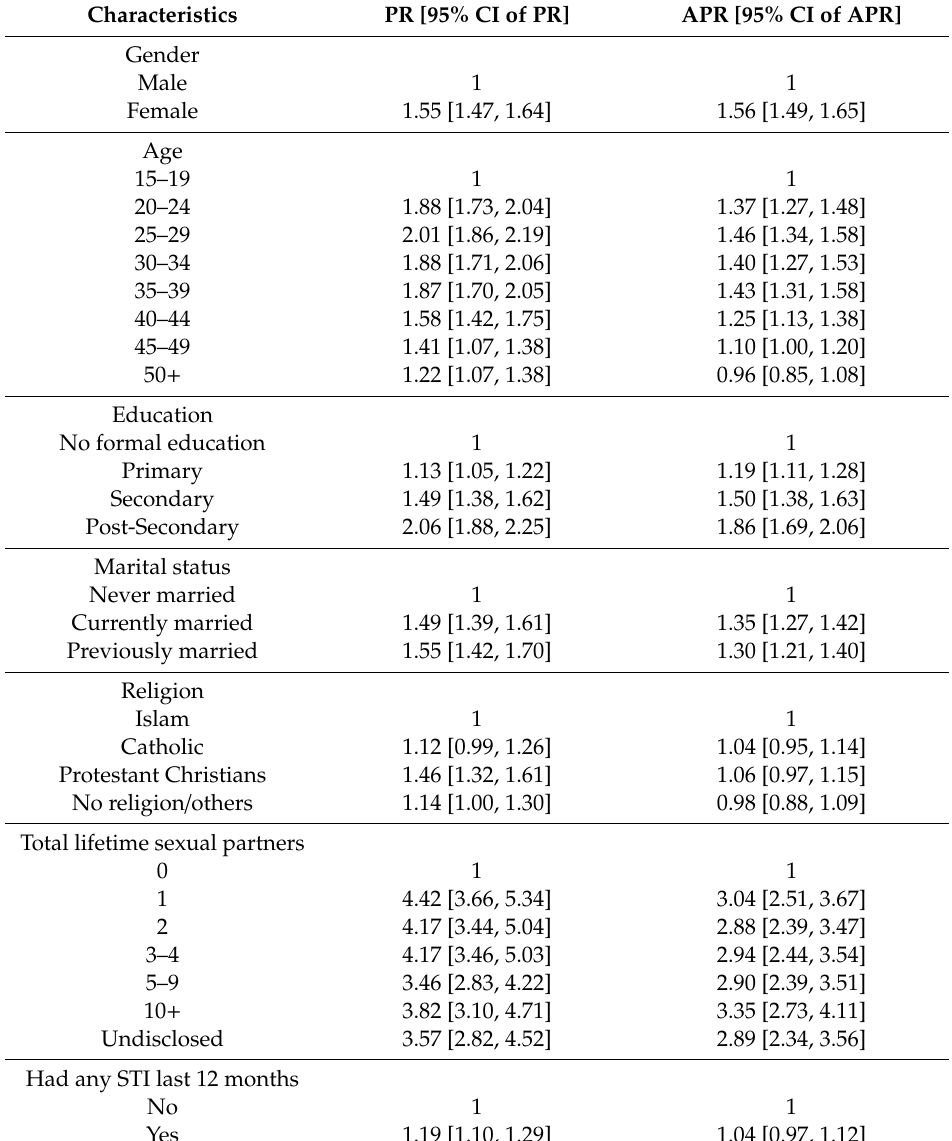
Table 2. Complex samples Poisson regression results of predictors of ever testing for HIV ( n = 12,995).